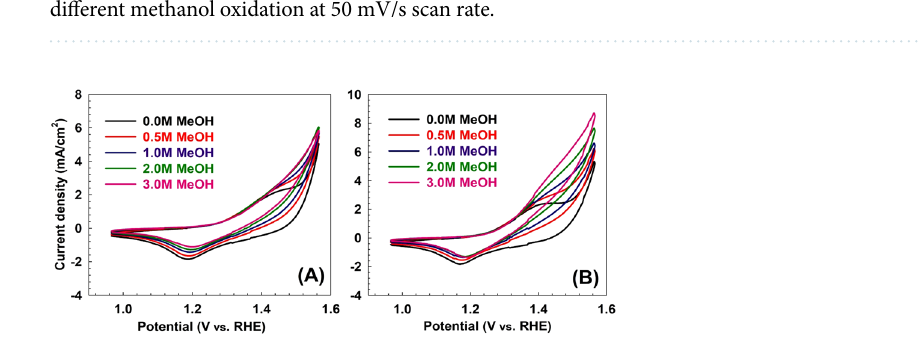
Figure 8. Cyclic voltammetry of samples calcined at 400 °C ( A ) before and ( B ) after MO adsorption for different methanol oxidation at 50 mV/s scan rate.